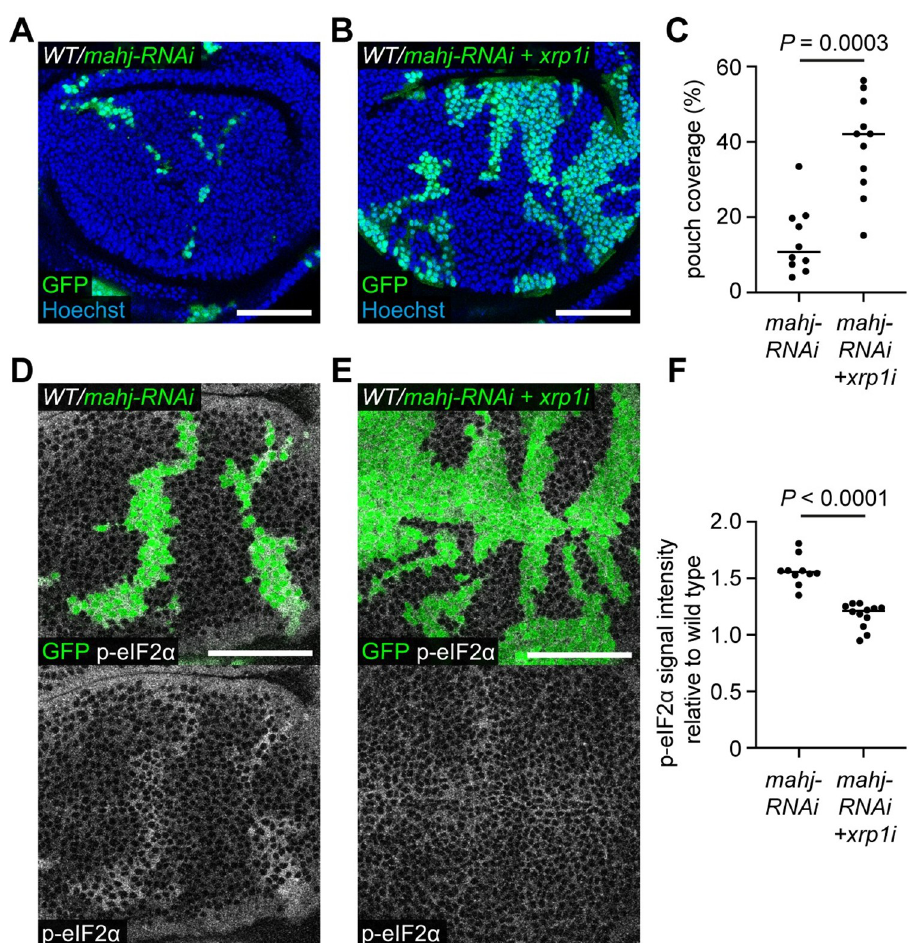
Fig 2. Xrp1 is required for competitive elimination of mahjong mutant cells. ( A-C ) Wild-type wing discs harboring mahj-RNAi cells (GFP positive) ( A ) or mahj-RNAi cells also expressing xrp1-RNAi (GFP positive) ( B ) with nuclei labelled in blue, and quantification of percentage coverage of the pouch ( C ) (n = 10 and 11, respectively; two-sided Mann–Whitney U-test). ( D-F ) Wild-type wing discs harboring mahj-RNAi cells (GFP positive) ( D ) or mahj-RNAi cells also expressing xrp1-RNAi (GFP positive) ( E ) immuno-stained for p-eIF2 α (grey) with quantification of p-eIF2 α signal intensity relative to wild-type cells ( F ) (n = 10 and 12, respectively; two-sided Mann–Whitney U-test). suggesting that Irbp18 can be effectively knocked down over this time window. Under this regime, xrp1 and irbp18-RNAi expressing cells had lower levels of p62 labelled aggregates than xrp1 expressing cells (S4B–S4D Fig), suggesting that Irbp18 is, at least partially, required for Xrp1 to activate proteotoxic stress. This is consistent with the earlier observation that the elim- ination of Xrp1 overexpressing cells from mosaic tissues can be rescued by a mutation in Irbp18 [29]. Overall, this data indicates that Xrp1, along with Irbp18, is responsible for induc- ing proteotoxic stress and the oxidative stress response in Rp/+ cells, which may explain why removal of Xrp1 or Irbp18 so effectively rescues Minute competition. If Xrp1 and Irbp18 are required in cell competition because they induce proteotoxic stress, then inducing proteotoxic stress by other means should lead to the loser status in an Xrp1- and Irbp18- independent manner. To test this hypothesis, we induced proteotoxic stress by well- established means. eIF2 α is phosphorylated in response to proteotoxic stress, leading to global attenuation of translation [30,31]. However, sustained increase in p-eIF2 α has also been